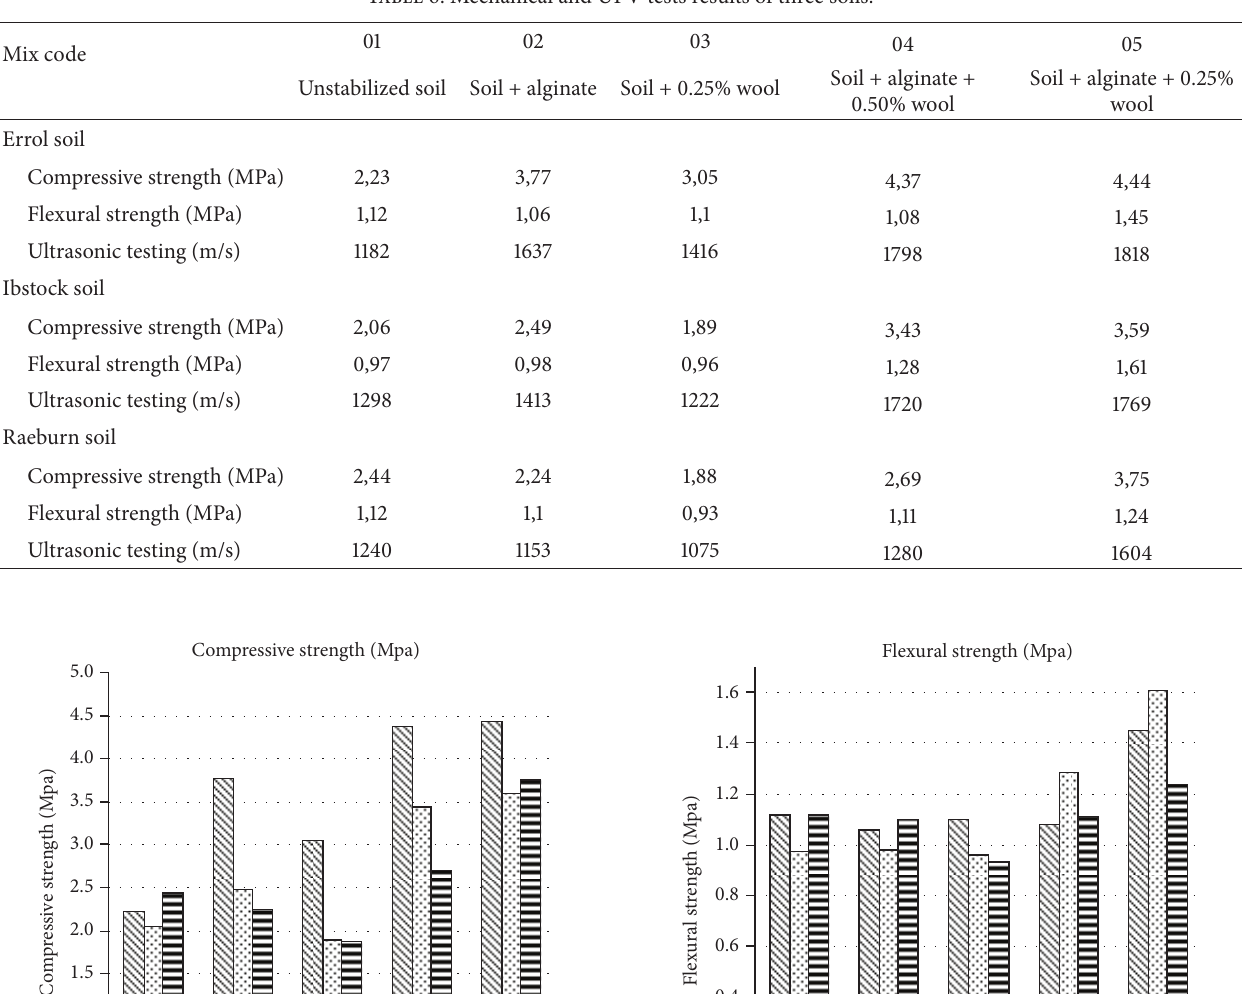
Table 6: Mechanical and UPV tests results of three soils.